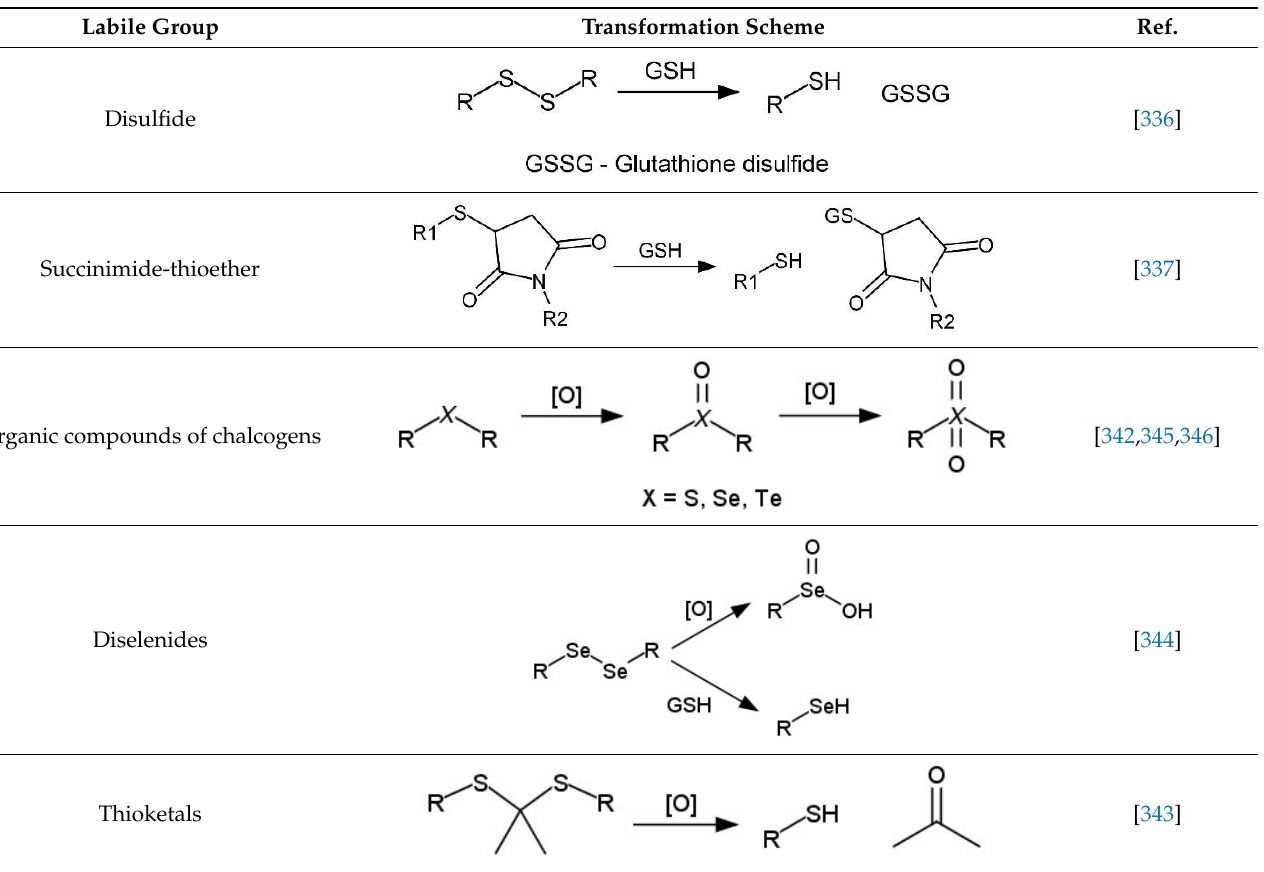
Table 3. List of labile groups sensitive to GSH and ROS.